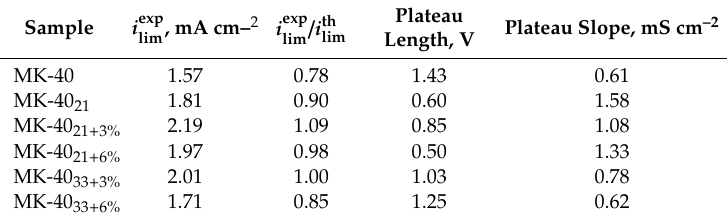
Figure 4. Current-voltage characteristics (solid lines) and the di ff erence in pH between the outlet and inlet solution passing through the desalination compartment of the electrodialysis cell (dashed lines) of the pristine and modified membranes. Table 3. Some parameters of current-voltage curves, current-voltage characteristics